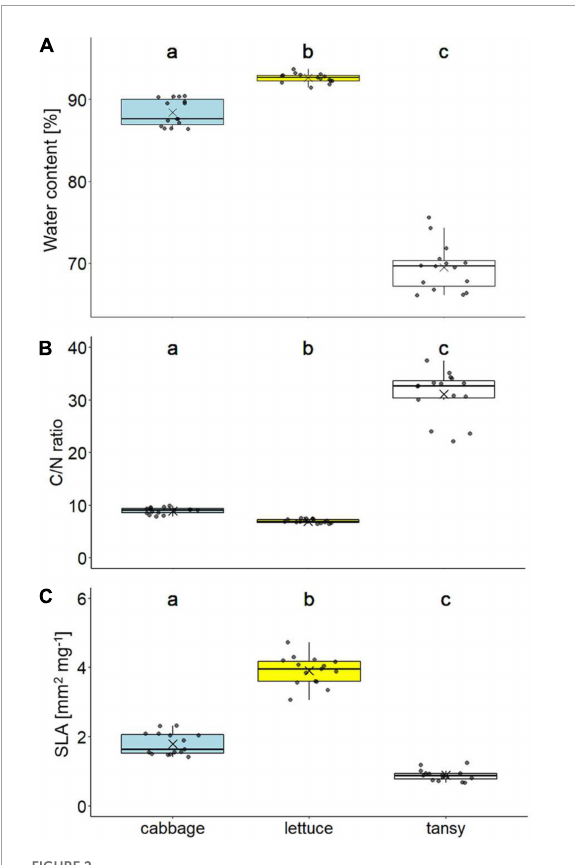
FIGURE2 Leaf quality traits of different food plant species (cabbage: Brassica rapa ; lettuce: Lactuca sativa ; tansy: Tanacetum vulgare ) with (A) water content, (B) carbon-to-nitrogen (C/N) ratio, and (C) specific leaf area (SLA; n = 15 per plant species). Box plots show the means (as crosses), medians (horizontal lines) and interquartile ranges (IQR; boxes), the whiskers extend to the most extreme values with max. 1.5 times the IQR. Individual values are plotted as dark circles. Statistical analyses were done with Kruskal–Wallis tests followed by pairwise Mann–Whitney U -tests. Significant differences ( p < 0.05) are indicated by different lowercase